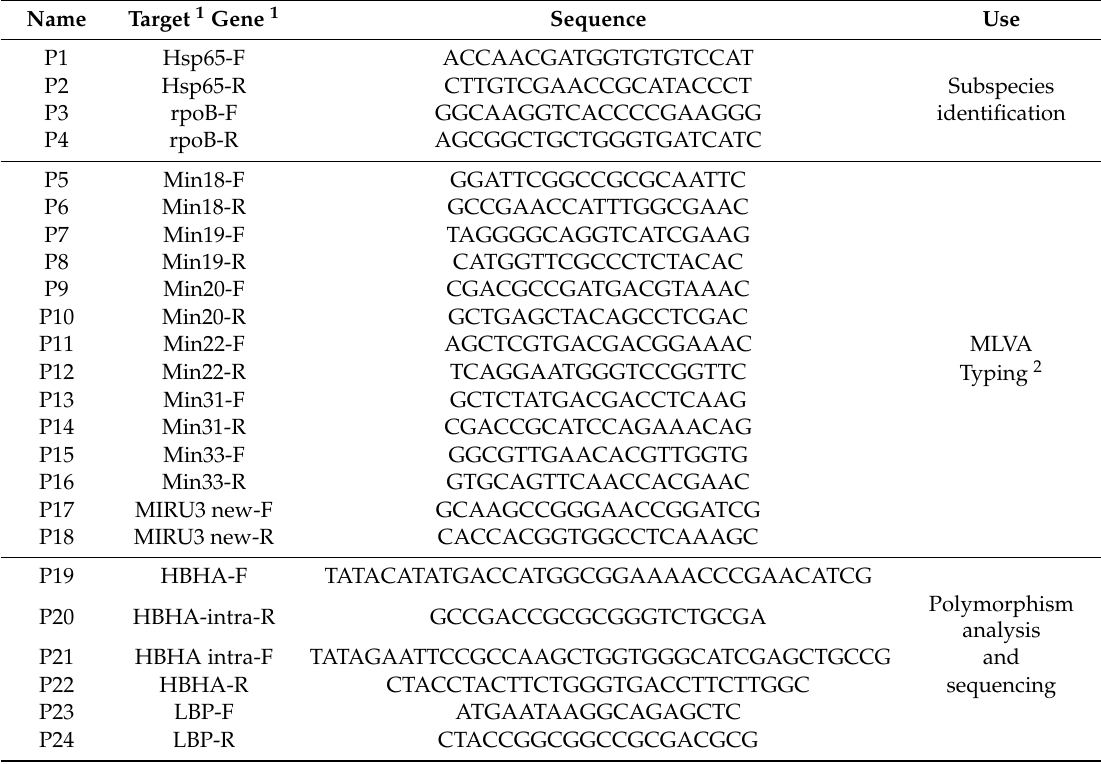
Table 2. List of primers used in this